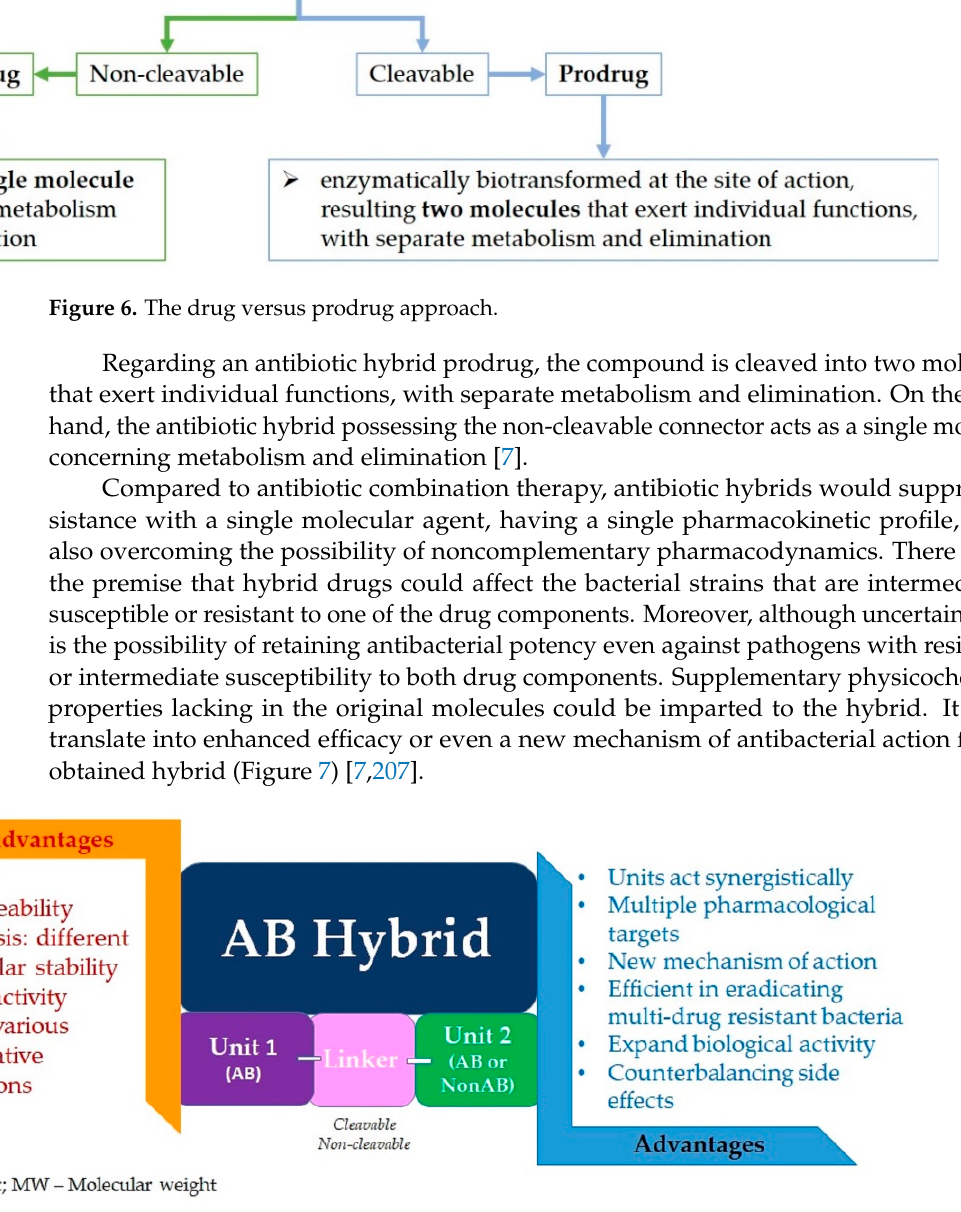
Figure 7. Advantages and disadvantages of antibiotic hybrids.